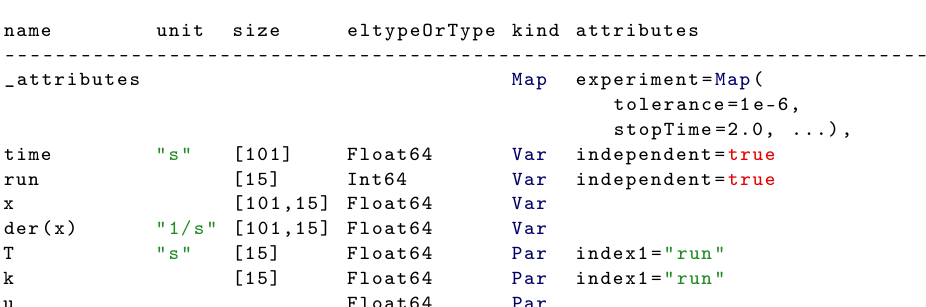
Figure 6. Parameter variation of model firstOrder with T = 0.1,0.2,0.3,0.4,0.5, k = 0.7,0.8,0.9, u ( t ) = 1.0, and x 0 = 0. Listing 10. Parameter variation of model firstOrder resulting in one Signal Table based on 15 simula- tions in which the first independent variable is "time" and the second independent variable is "run" with values = 1, 2, ...,